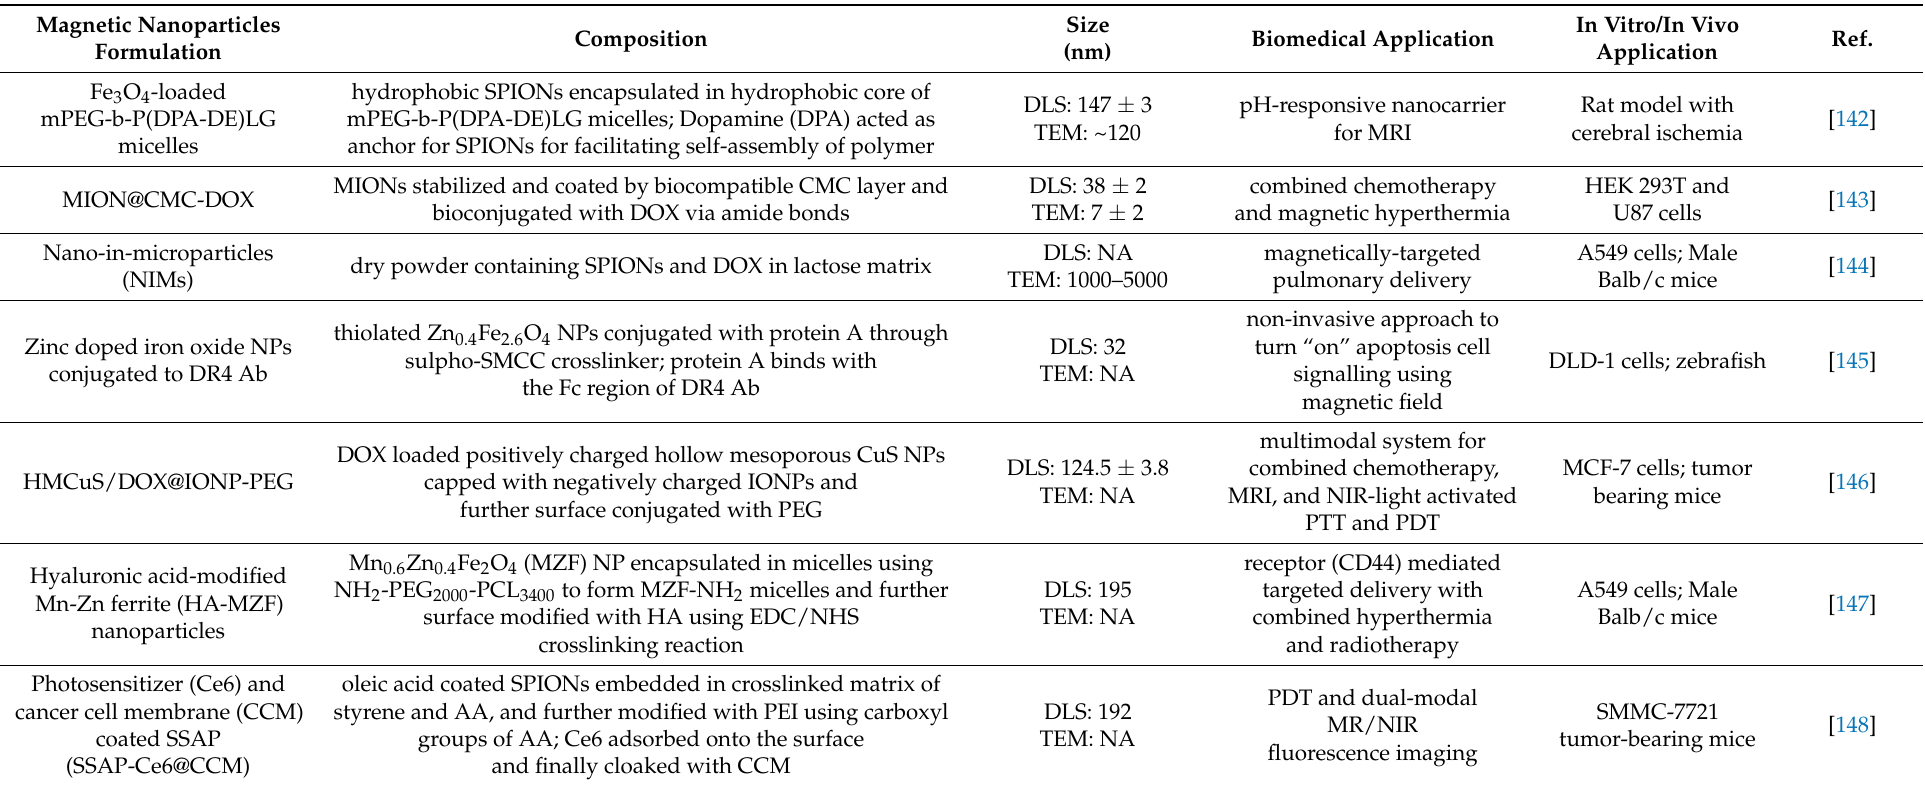
Table 3. Some of the important magnetic nanoparticle formulations employed for various biomedical applications (NA: not available). Magnetic Nanoparticles